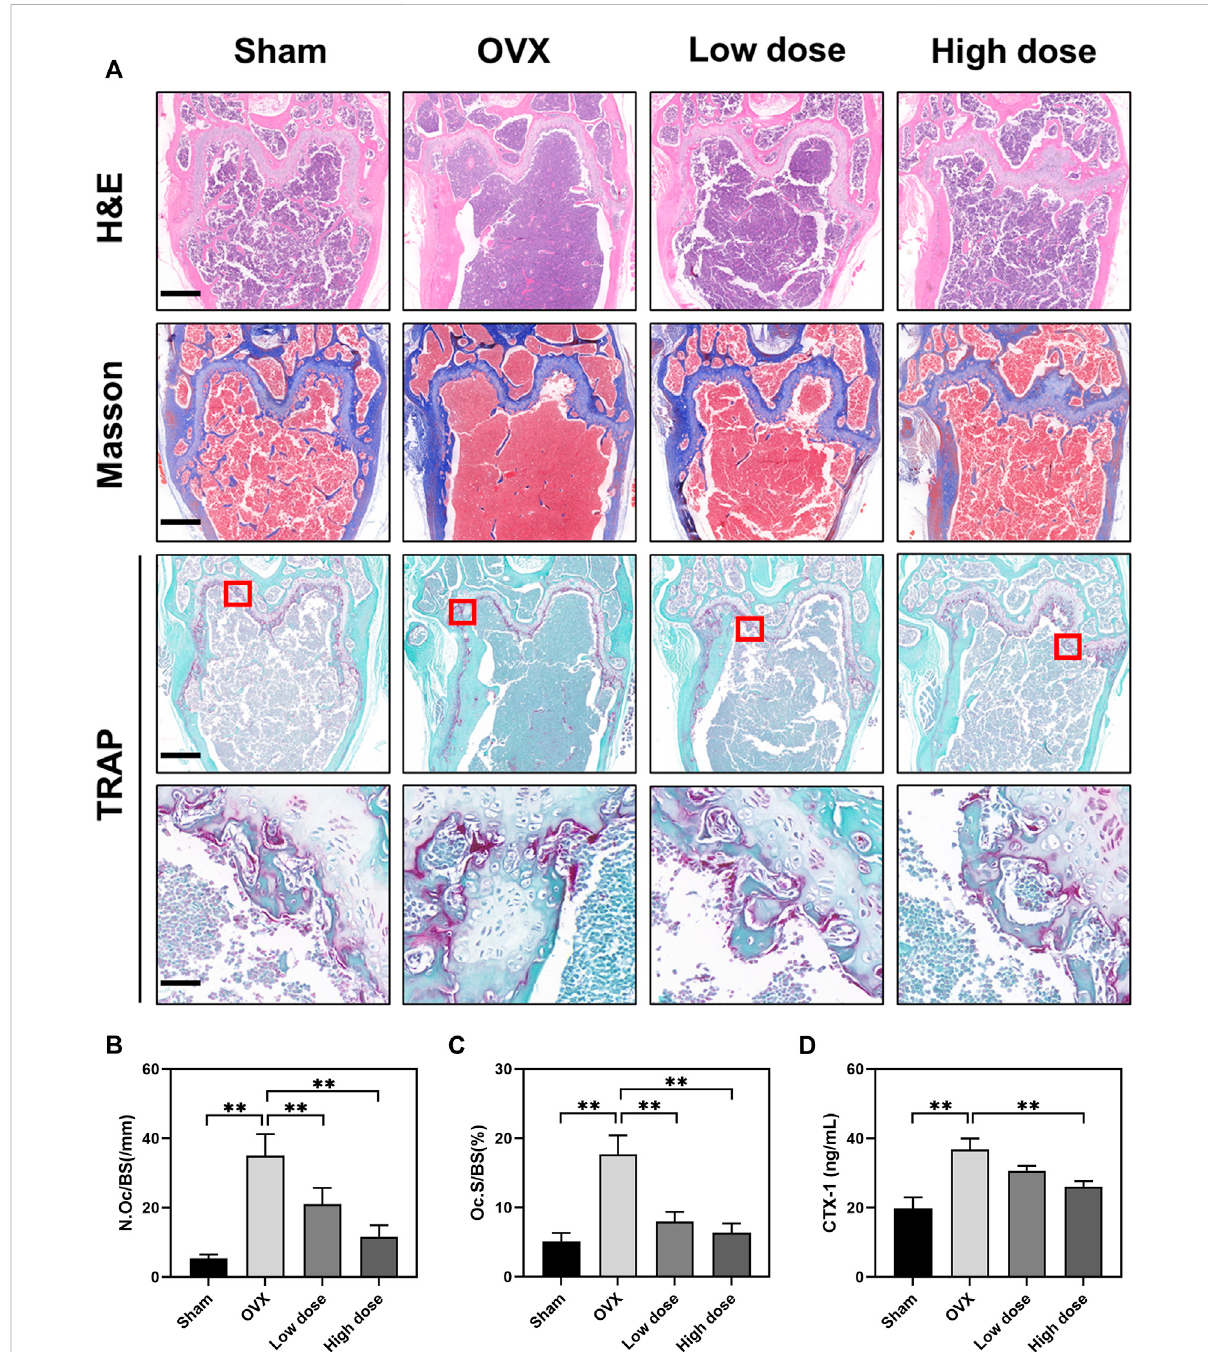
FIGURE 6 BBM inhibits osteoclastogenesis in ovariectomized mice. (A) Representative images of distal femur sections stained with H&E, Masson ’ s trichrome and TRAP (scale bar = 500 μ m; scale bar = 50 μ m in the enlarged pictures). (B – C) Quantitative analysis of N. Oc/BS (B) and Oc S/BS (C) in the TRAP staining images of distal femurs. (D) Serum levels of the CTX-1 bone resorption marker quanti fi ed by ELISA. * p < 0.05 and ** p < 0.01 compared to the OVX